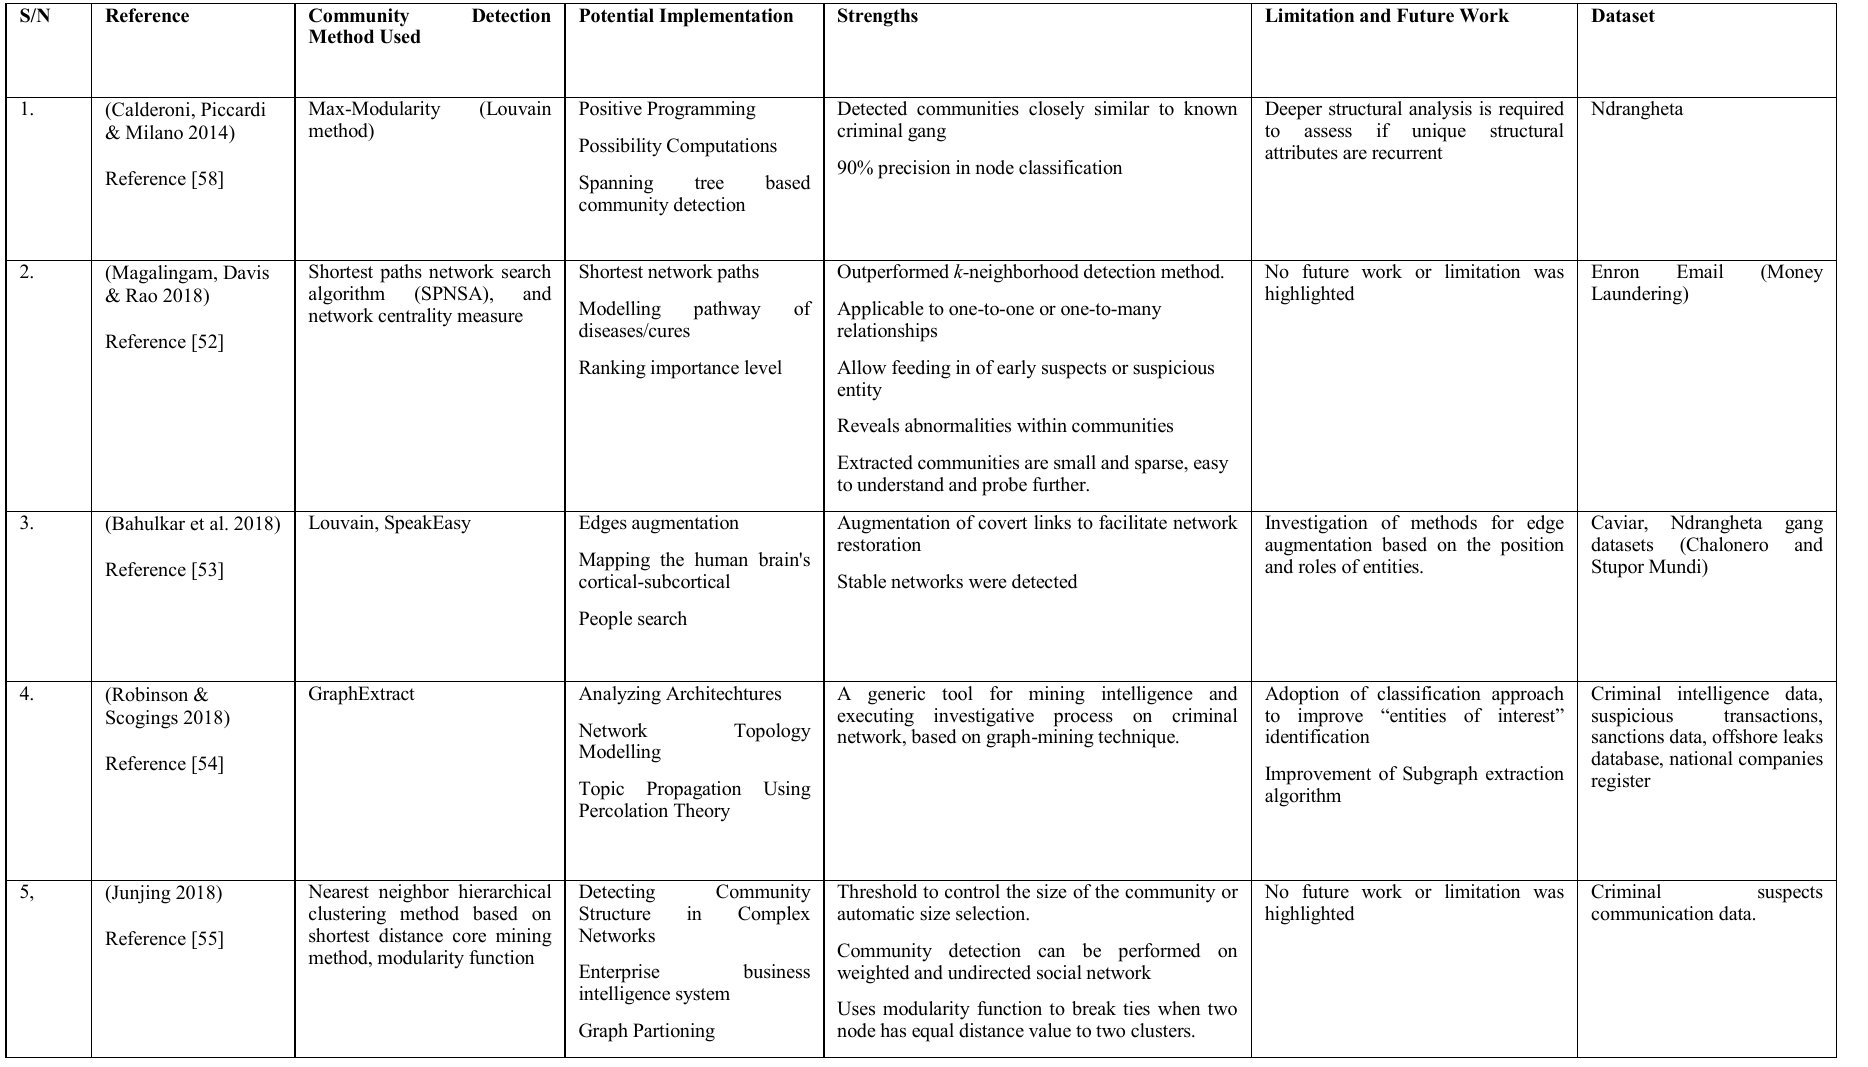
Table 3. Review of Related Literatures on Criminal Communities